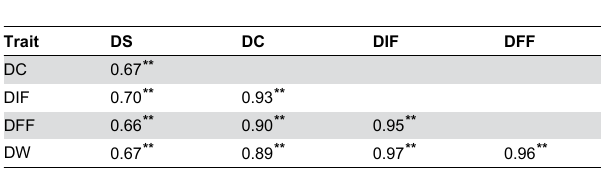
Table 2. Inter-trait Pearson correlation